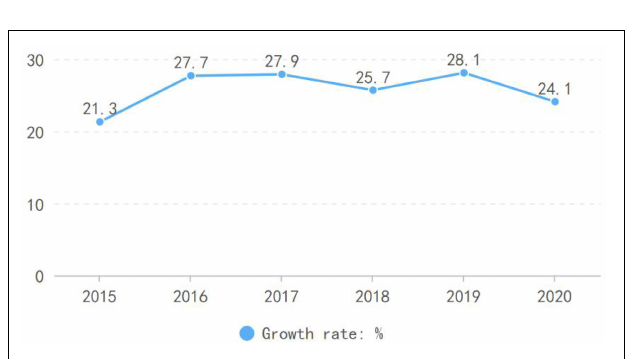
FIGURE 1 | Scale statistics of online education market from 2015 to 2020 in China. Source: https://bg.qianzhan.com/trends/detail/506/210730- 5d593518.html.